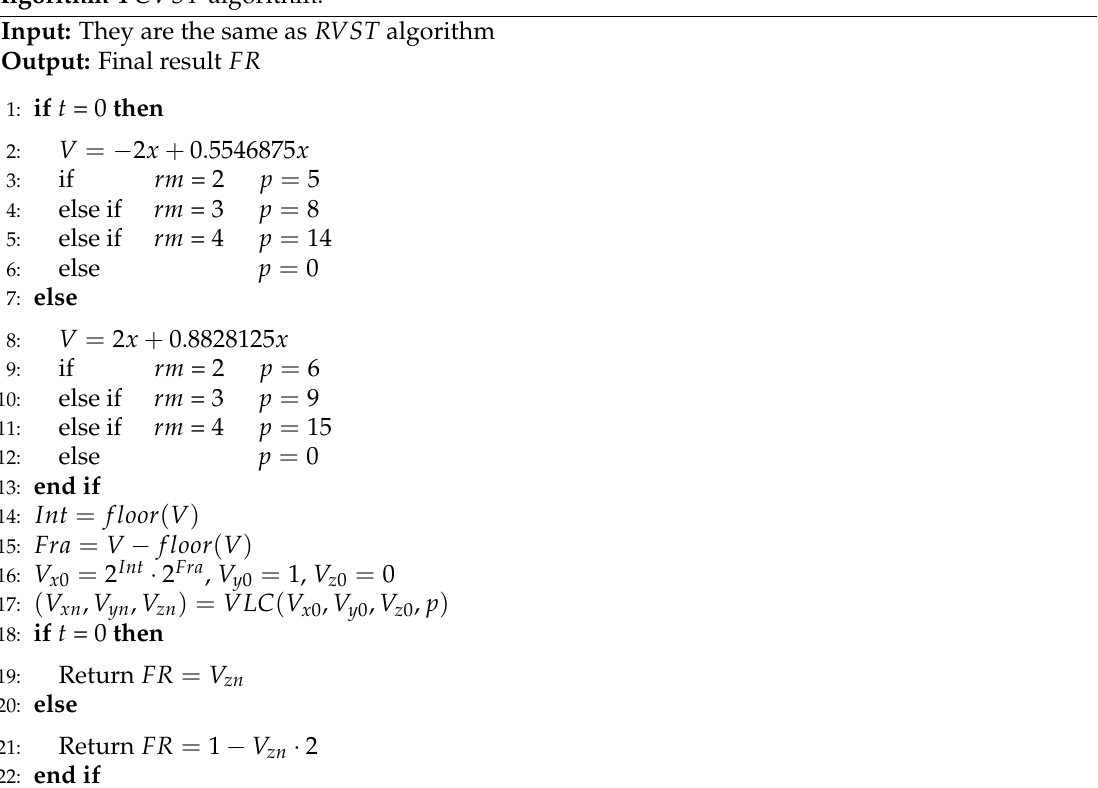
Algorithm 4 CVST